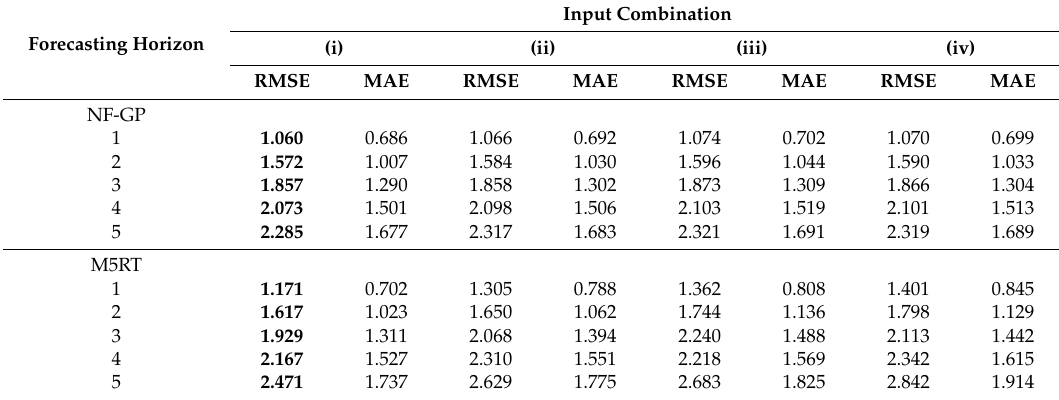
Table 9. NF-GP and M5RT results in wind speed prediction for multiple